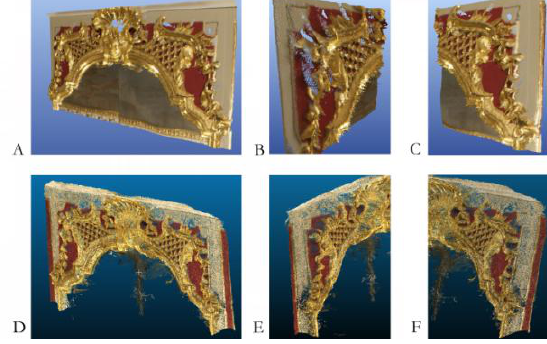
Figure. 8 Cloud of points of gilded details TLS (A, B, C –